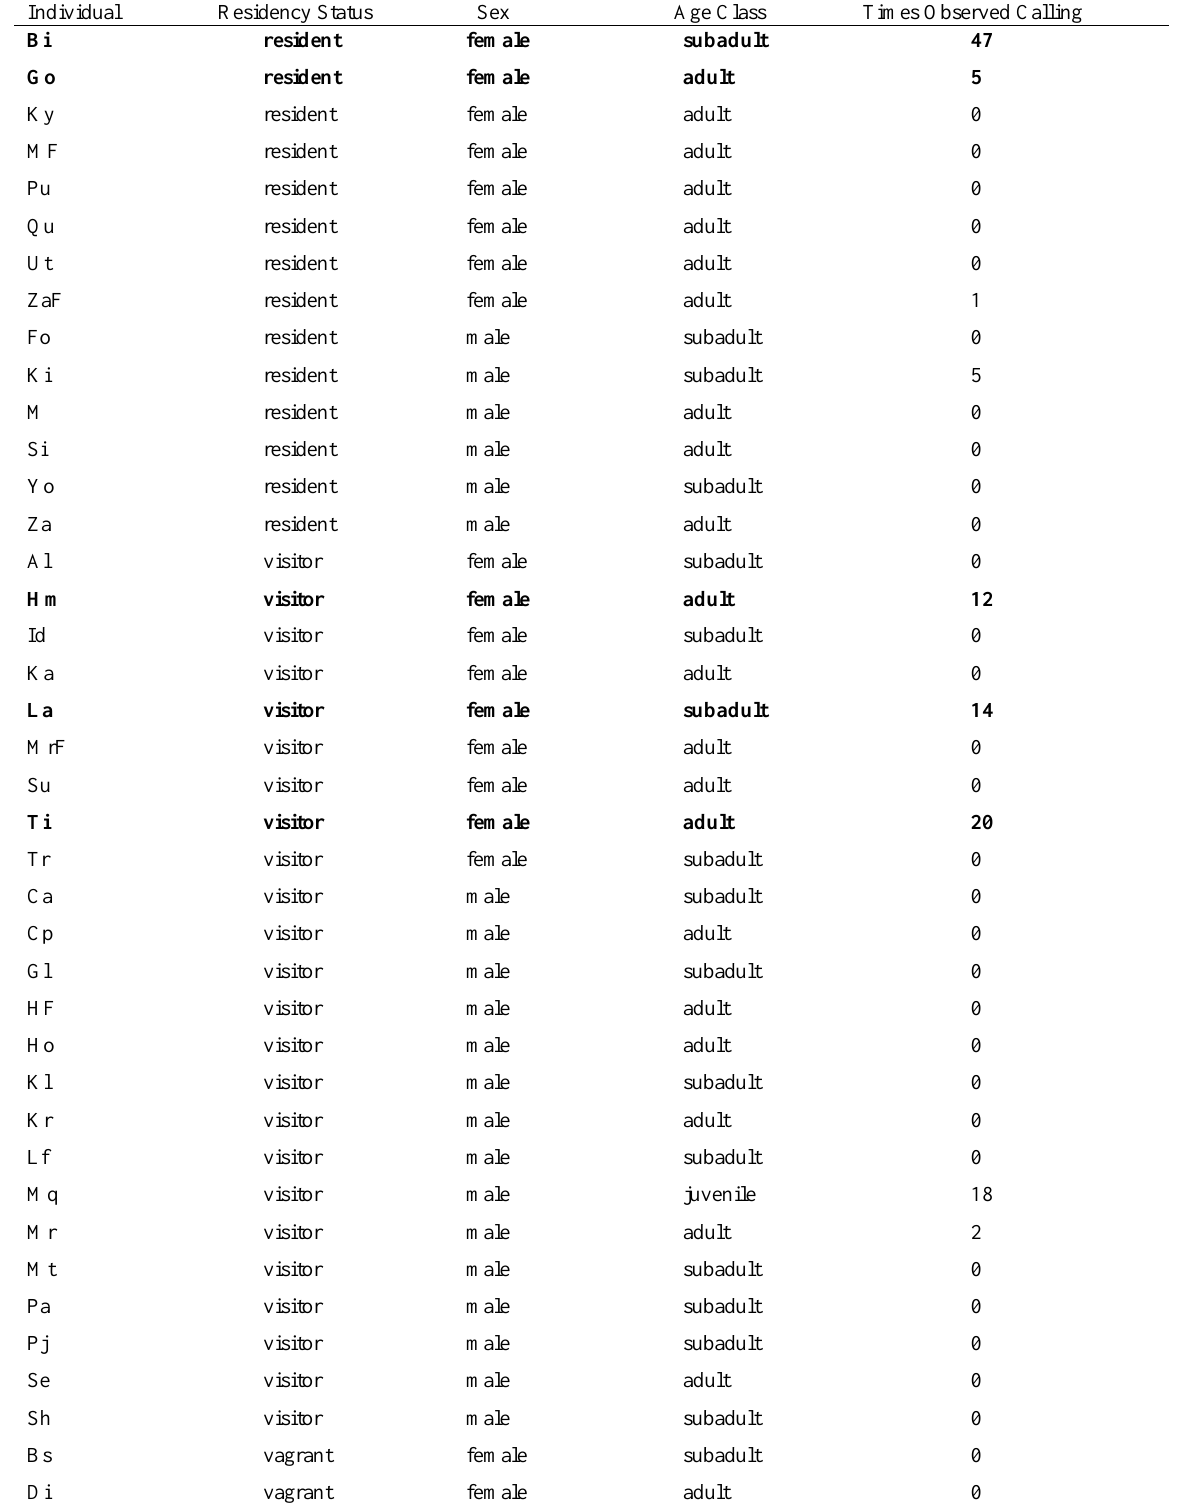
Individuals with Residency Status, Sex, Age Class, and Times Observed Calling ‘haa’ Throughout the Observation Period